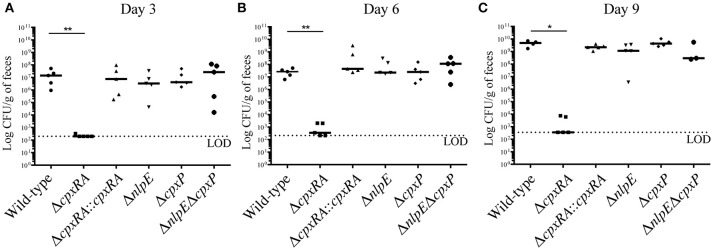
Bacterial burden in female C3H/HeJ mice after infection with Cpx TCS mutant strains of Citrobacter rodentium. Female C3H/HeJ mice were infected as described previously, and fecal bacterial burden was assessed at day 3 (A), 6 (B), and 9 (C) post infection by plating on MacConkey agar and counting Colony Forming Units (CFU). At day 9 post infection, due to significant illness manifestation, in the absence of fecal matter, colon was homogenized and plated on MacConkey agar. A Mann-Whitney test was used to determine significance between each mutant strain and wild-type (**p < 0.01; *p < 0.05). (LOD = Limit of detection; day 3, day 6: n = 5; day 9: n = 3–5; black bar denotes the median).